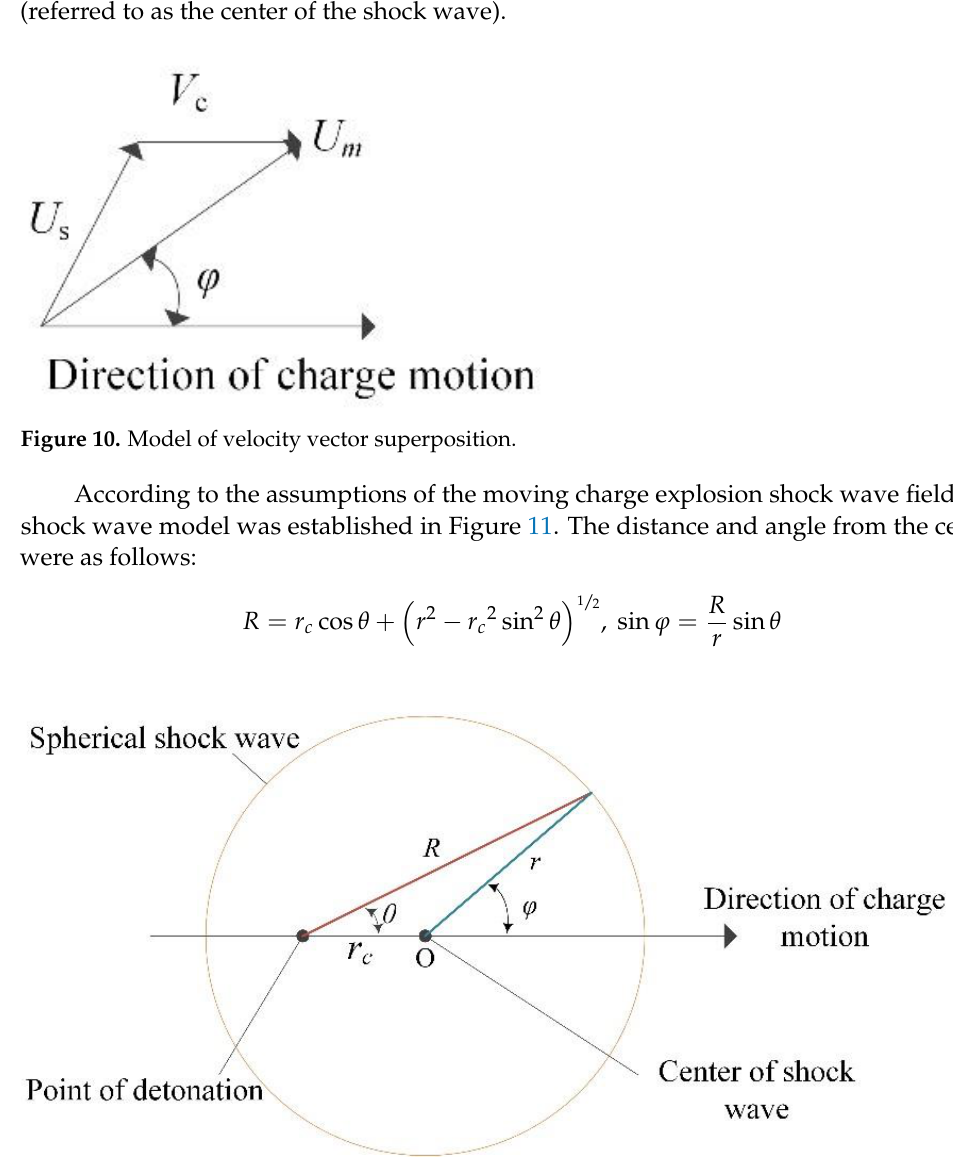
→ U s is the shock wave